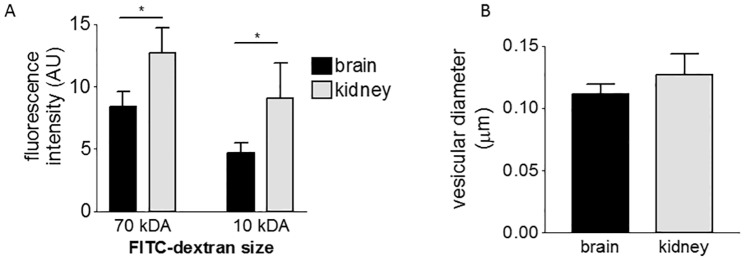
Comparison of the rate of endocytosis and vesicular size in endothelial cells.(A) Endocytosis of dextran measured by FACS, after 1hr incubation, comparing brain and kidney endothelial cells (mean ± SEM, 3 independent experiments, repeated-measures ANOVA with Bonferroni multiple comparison post test, * P< 0.05). (B) Diameter of vesicles in brain and kidney endothelial cells (mean ± SEM of 3 independent experiments, unpaired t-test, no-significant difference).